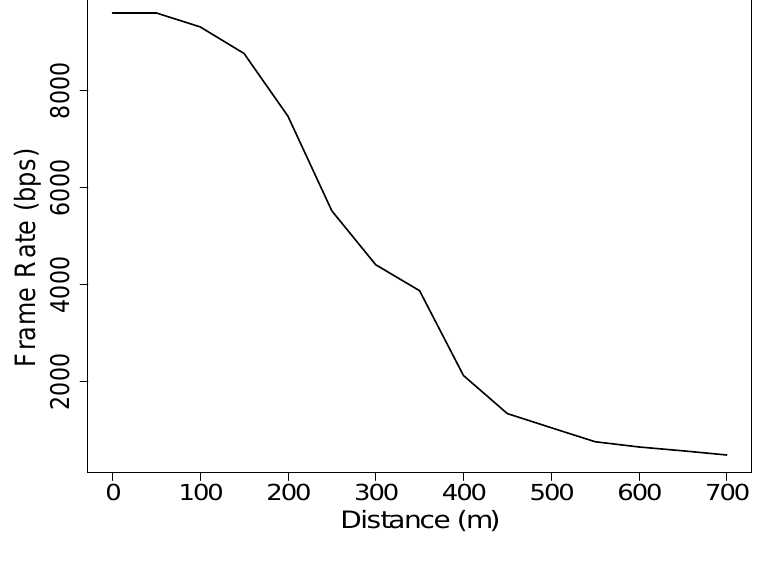
Figure 9. Average frame rate achieve in the Primary-Base station radio link experiment for different transmission